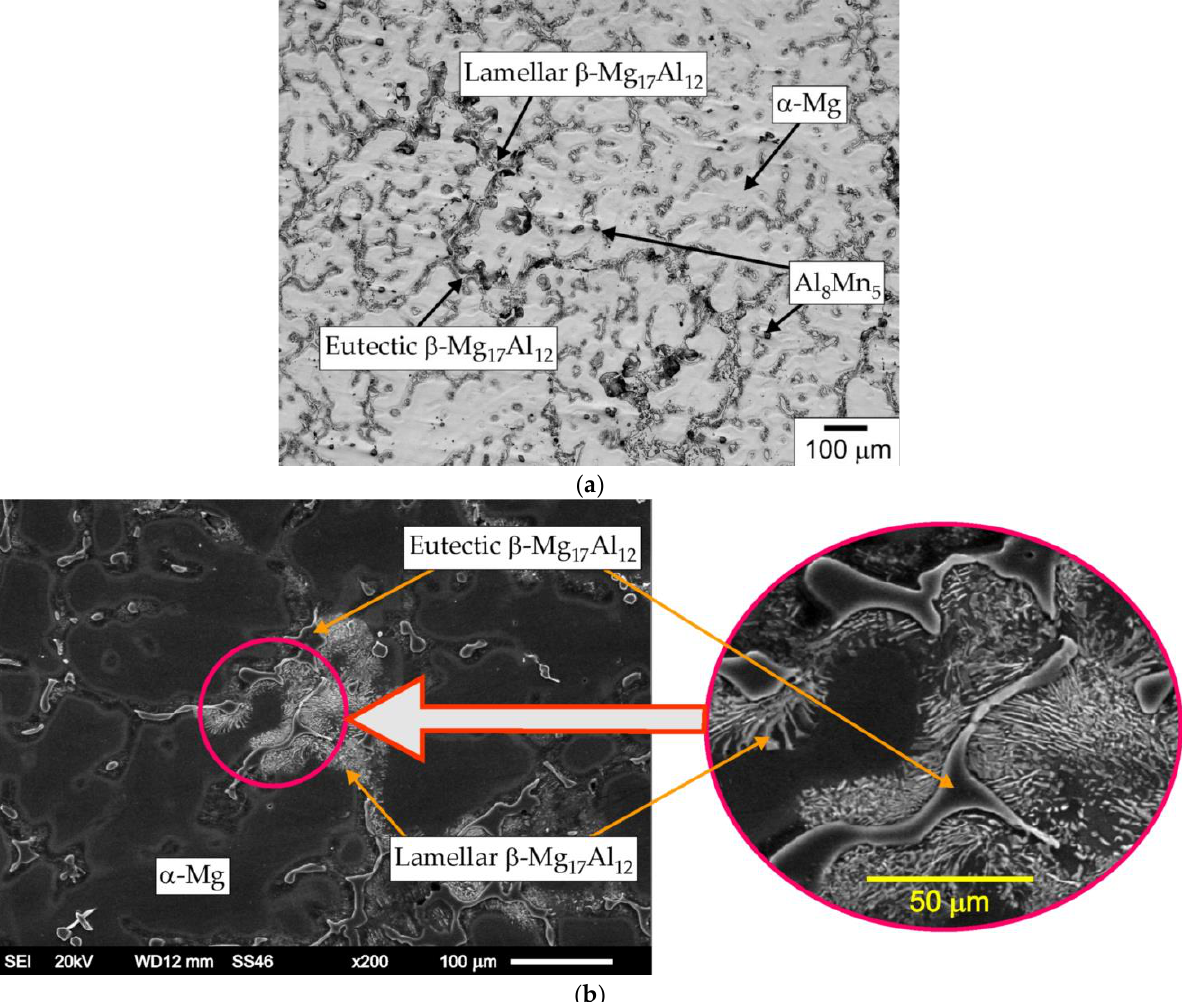
Figure 2. Microstructure of AZ91 alloy, etched cross-section, ( a ) light microscopy, ( b ) SEM.